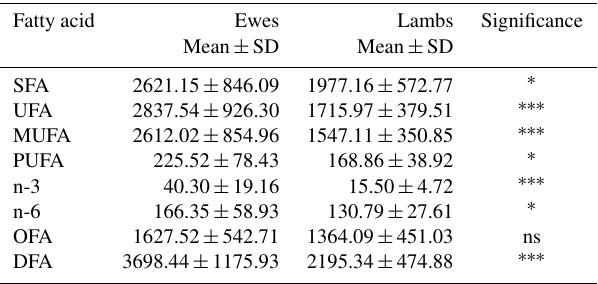
Table 5. Fatty acid group content (mg per 100g muscle) of ewe and lamb musculus biceps femoris